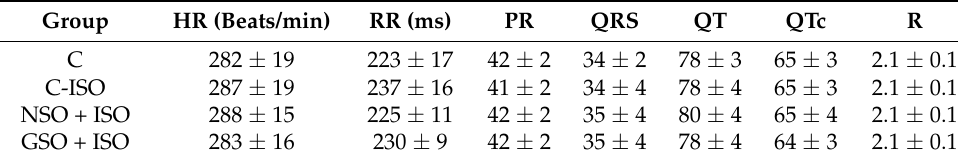
Table 5. Basal values of ECG parameters recorded at the beginning of the experiment. C